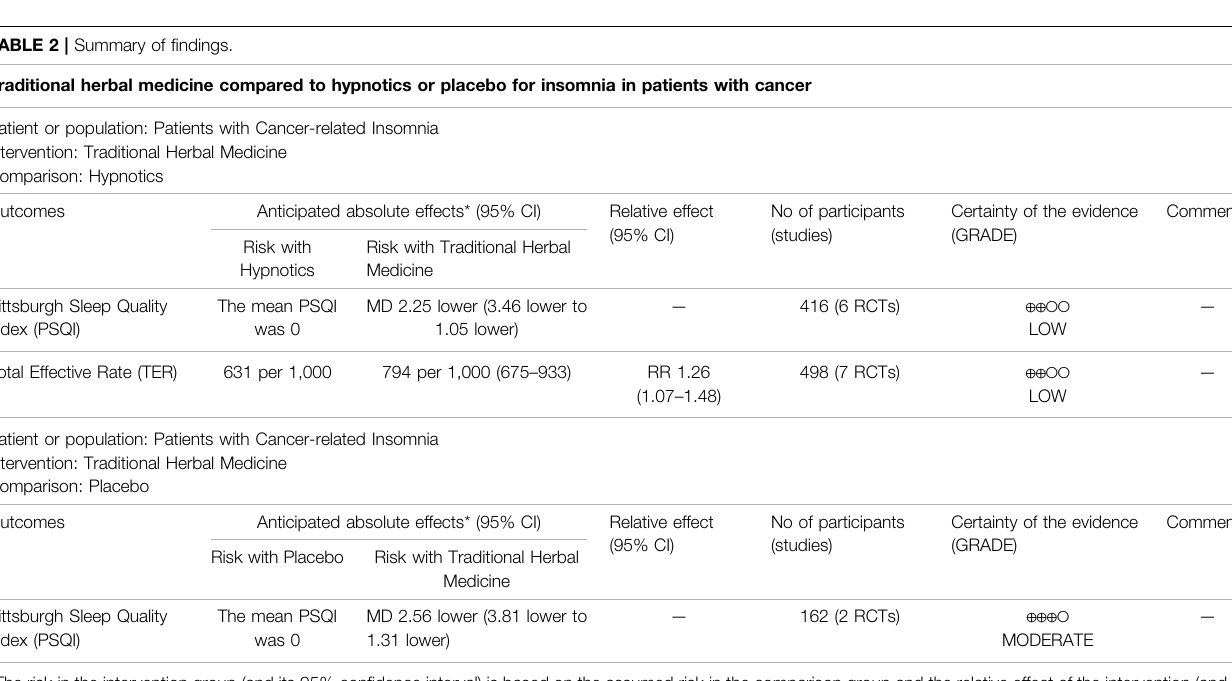
FIGURE 3 | Forest plot of the pittsburgh sleep quality index for THM versus hypnotics. THM, traditional herbal medicine; GBAD, Guben Anshen decoction.